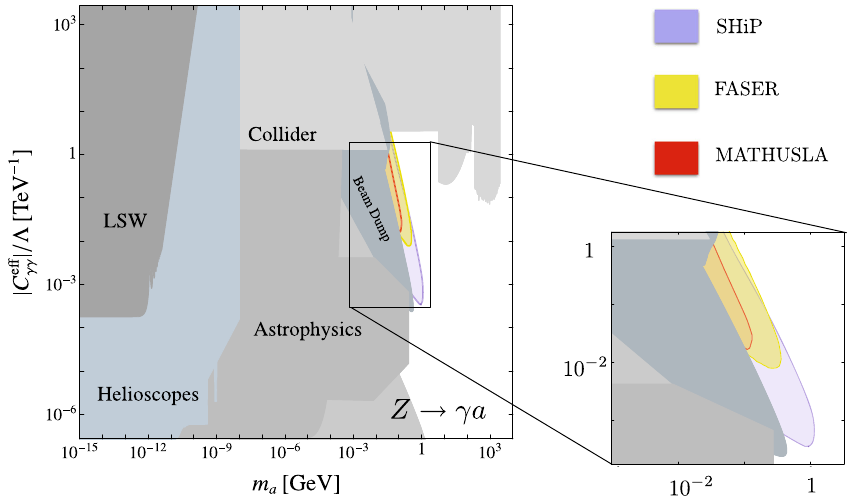
Fig. 19 Projected reach in searches for h → Za → (cid:10) + (cid:10) − + μ + μ − solid contours correspond to a branching ratio of Br ( a → μ + μ − ) = 1, and contours showing the reach for smaller branching ratios are dotted. (left)and h → aa → μ + μ − + μ + μ − (right)decayswithATLAS/CMS √ s = 14TeV center-of-mass The sensitivity regions are based on 4 (MATHUSLA) and 100 (LHC) (green) and MATHUSLA (red) with expected signal events, respectively energy and 3ab − 1 integrated luminosity. The parameter region with